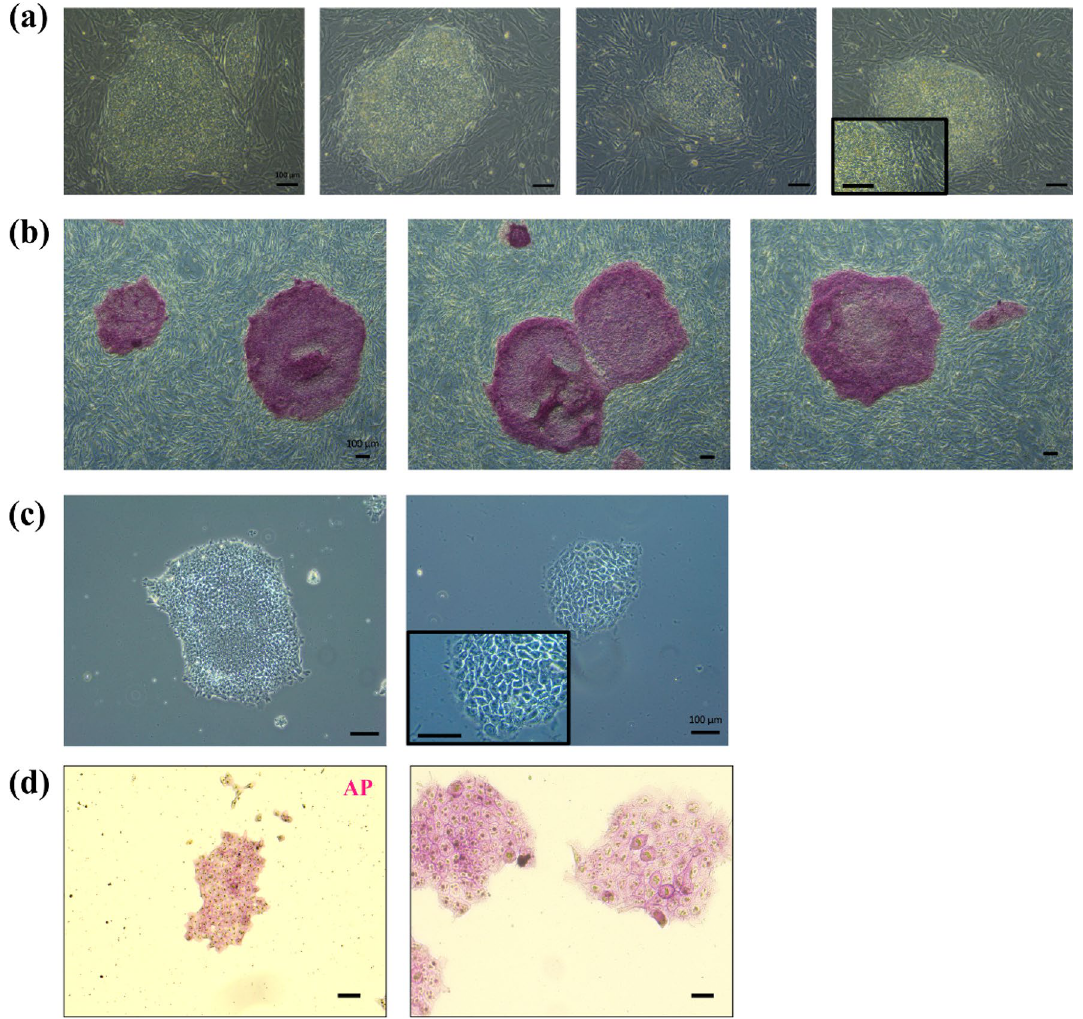
Figure 1. Rhesus induced pluripotent stem cells generated by piggyBac transposition. ( a ) Rhesus iPSC morphology on feeder cells (left to right DPZ_iRhpb#1–4), ( b ) Alkaline phosphatase staining (left to right DPZ_iRhpb#1–3), ( c ) PSC adaptation to feeder-free culture conditions. Left image: Rh366.4 ESCs (Rh_ESC), right image: DPZ_iRhpb#4, ( d ) Alkaline phosphatase staining in feeder-free culture. Left image: DPZ_iRhpb#4, right image: Rh_ESC (Scale bars in ( a – c ) 100 µm, in ( d ) 50 µm).